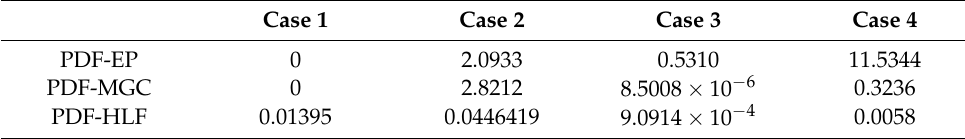
Table 3. Control errors of the three